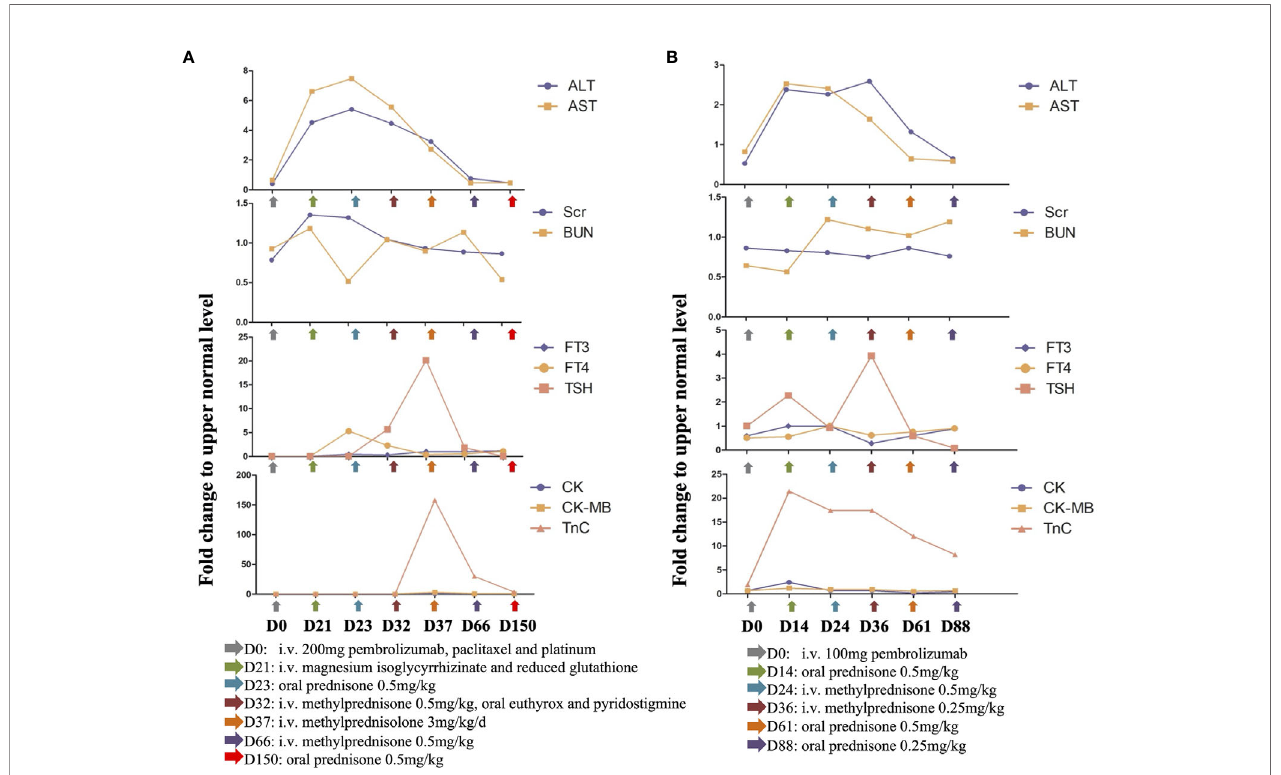
FIGURE 3 | (A) Mild irAEs occurred three weeks (D21) post the administration of 200 mg pembrolizumab, which includes grade 2 to 3 liver abnormality, grade 1 kidney dysfunction, grade 1 hypothyroidism and grade 2 myocarditis. Steroids were tapered slowly over a 5-month (D150) period with gradual recovery. (B) Grade